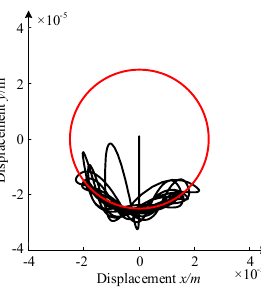
Figure 8. Axis trajectory under upper unit failure mode.